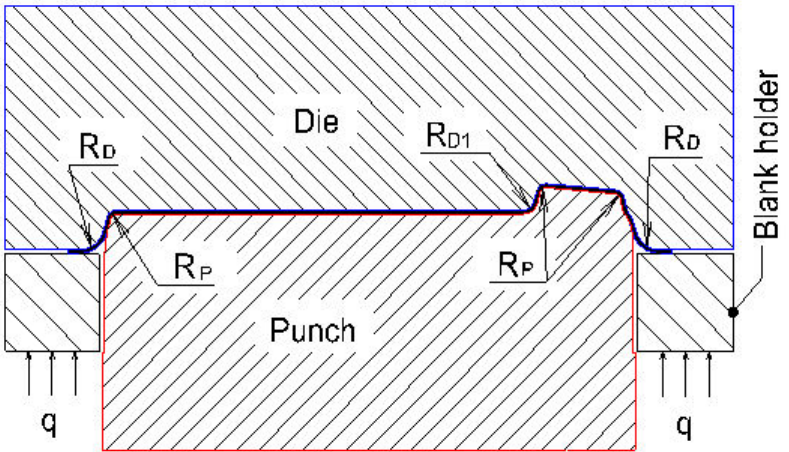
Figure 1. Geometry parameters of the die and punch; R D is the die edge radius, R D1 is the pocket radius on the bottom of die, R P is the punch nose radius and q is holder